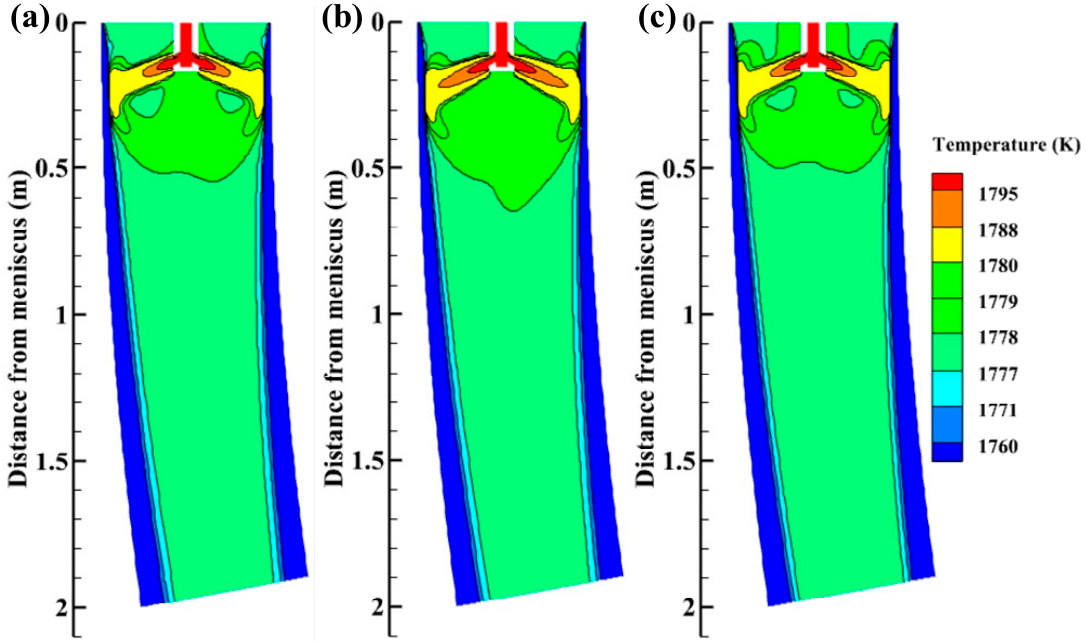
Figure 9. Temperature distributions on the plane Y = 0 m without M-EMS ( a ) –15° SFN, ( b ) 0° SEN, and ( c ) +15° SFN.